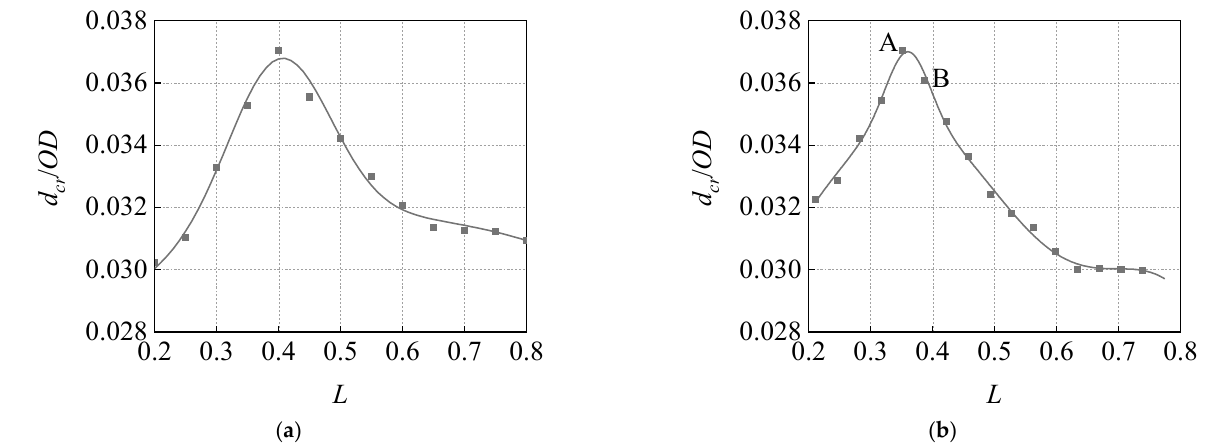
Figure 17. Influence of corrosion length and width on critical dent depth: ( a ) corrosion axial length, ( b ) corrosion circumferential width.